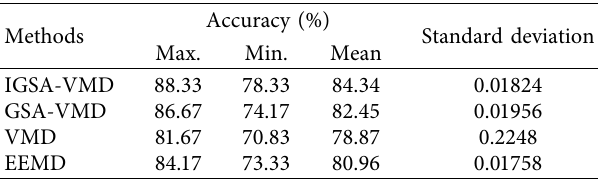
Table 7: The cutting state recognition results of the four methods without using PCA.